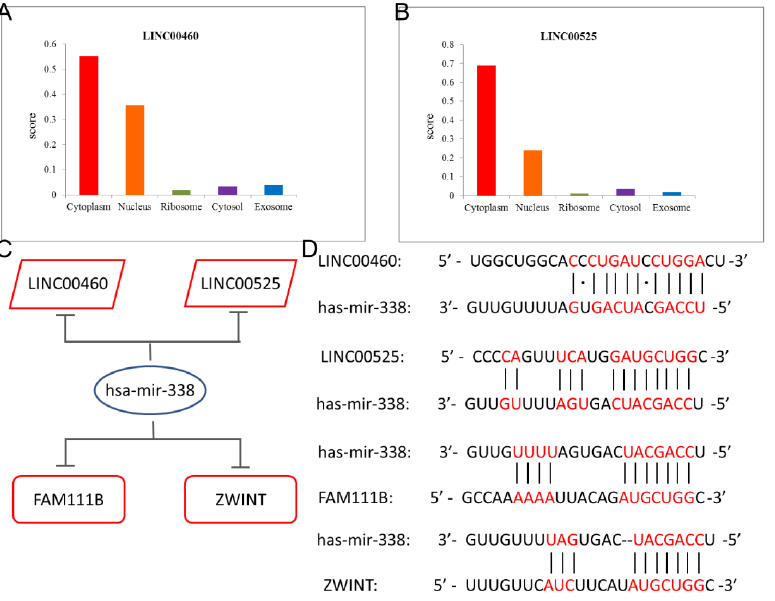
Figure 3. LUAD prognostic model verification of gene expression by RT-qPCR. ( A , B ) Subcellular localization of ( A ) LINC00460 and ( B ) LINC00525. ( C ) MiRcode, lncRNABase and TargetScan predicted the base pairing of target sites between has ‐ mir ‐ 338 with LINC00460, LINC00525, FAM111B and ZWINT. ( D ) LUAD prognostic model.